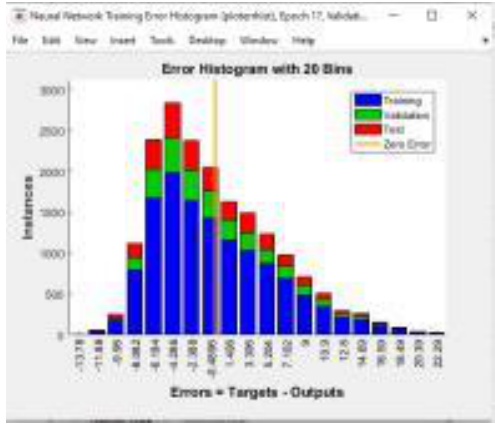
Figure 22 . shows the error histogram of the trained neural network for the training, validation and testing steps. This figure shows that the data fitting errors are distributed within a reasonably good range around zero.